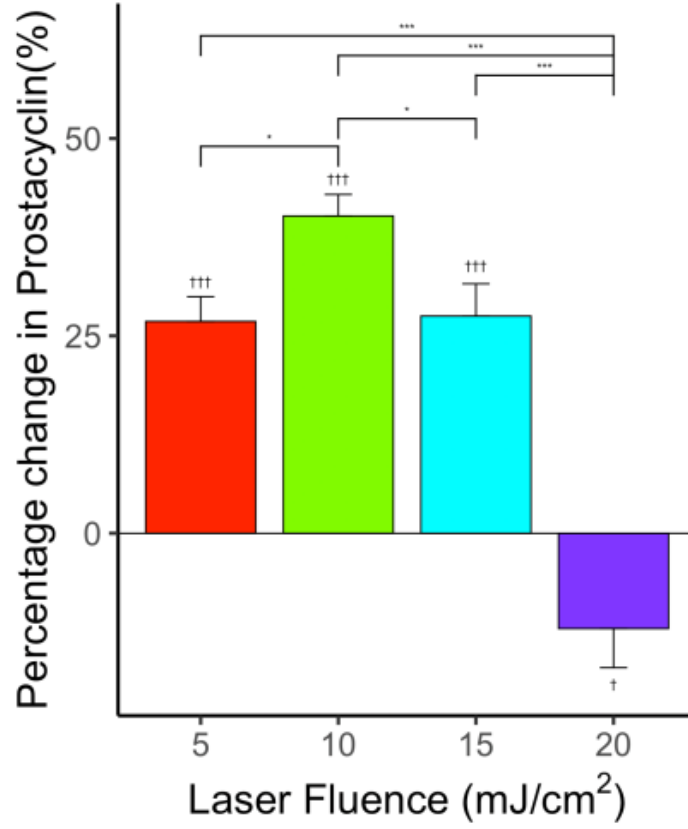
Figure 10. Effect of PUT on NO levels for various laser fluences—5, 10, 15, and 20 mJ/cm 2 — applied synchronously with ultrasound = 0.5 MPa showing a significant change in PGI 2 levels compared to control. n = 6 for each group. “*” indicates statistical significance between groups with p < 0.05. “***” indicates statistical significance between groups with p < 0.001. “†” indicates statistical significance between control and treatment group p < 0.05. “†††” indicates statistical significance between control and treatment group p < 0.001.